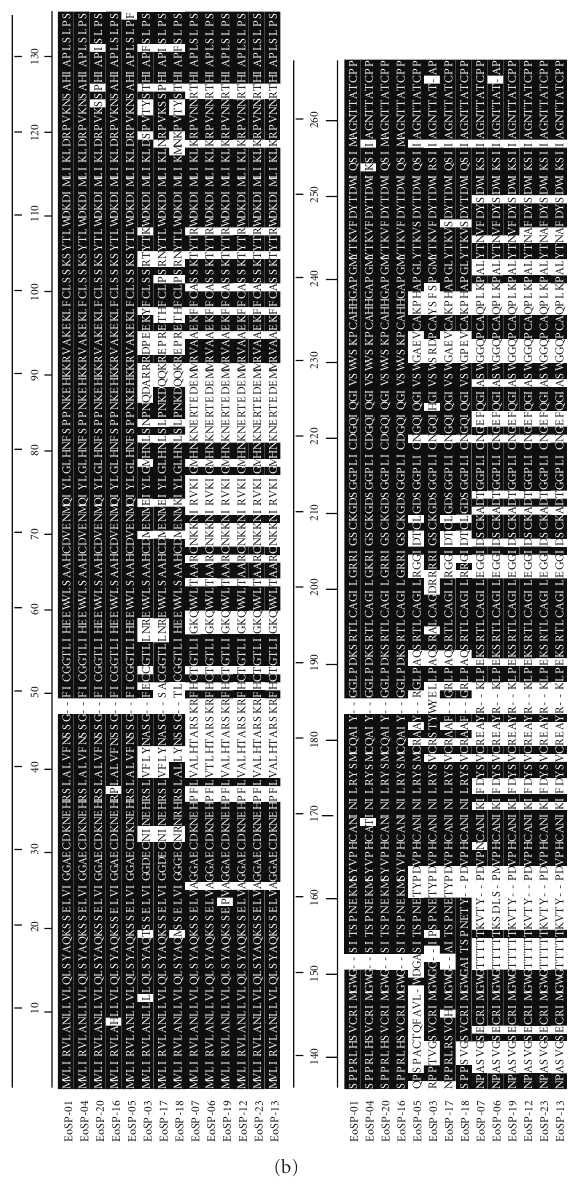
Figure 2: (a) The nucleotide sequence of the fourteen E . ocellatus venom gland cDNAs resulting from PCR amplification. (b) Deduced amino acid sequences of E . ocellatus venom gland serine protease